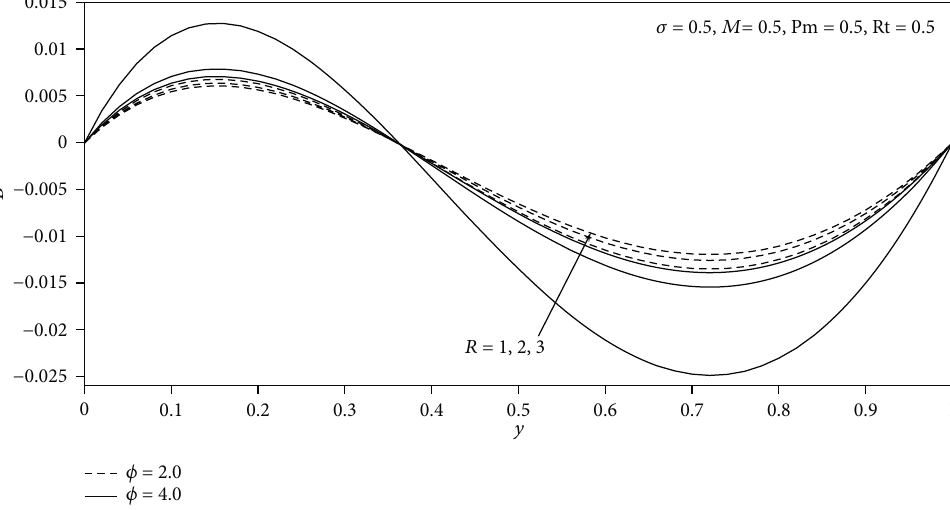
Figure 5: Induced magnetic fi eld for di ff erent values of ϕ and R